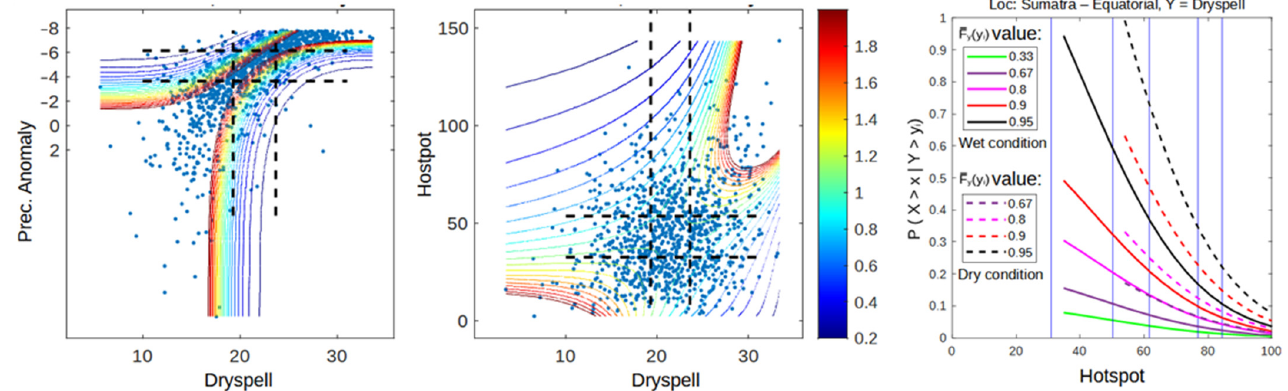
Figure 13. Dependency graph of each variable pair as well as conditional probability of 5% upper right quadrant from all observed data (January 2001–March 2020) on Sumatra with equatorial-type precipitation (1st dry season: January–March).